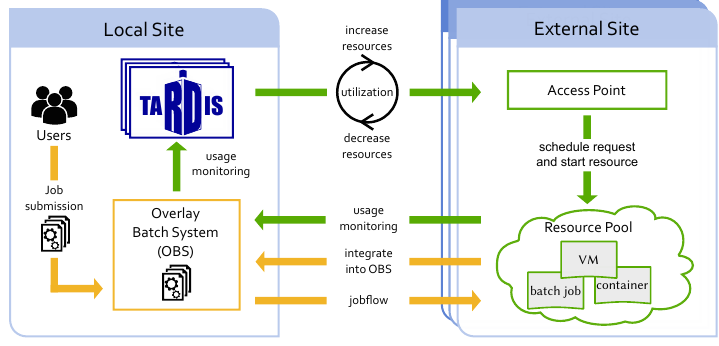
Figure 3. Simplified schematic diagram of the interplay between job submission, overlay batch system, TARDIS resource manager and opportunistic resource